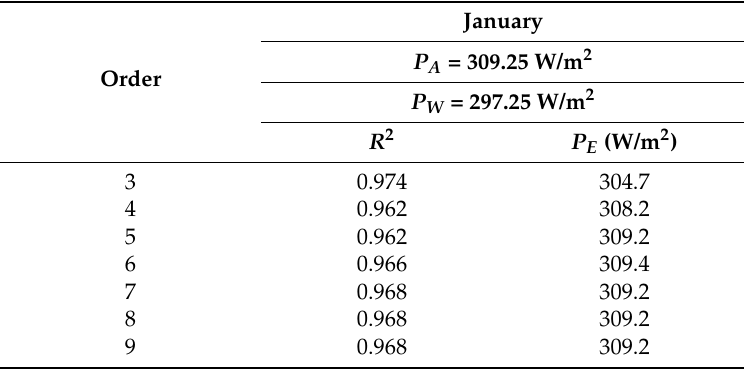
Table 5. Comparison of actual wind power densities ( P A ) with Weibull power densities ( P W ) and power densities based on MEP-based function for orders 3–9 ( P E